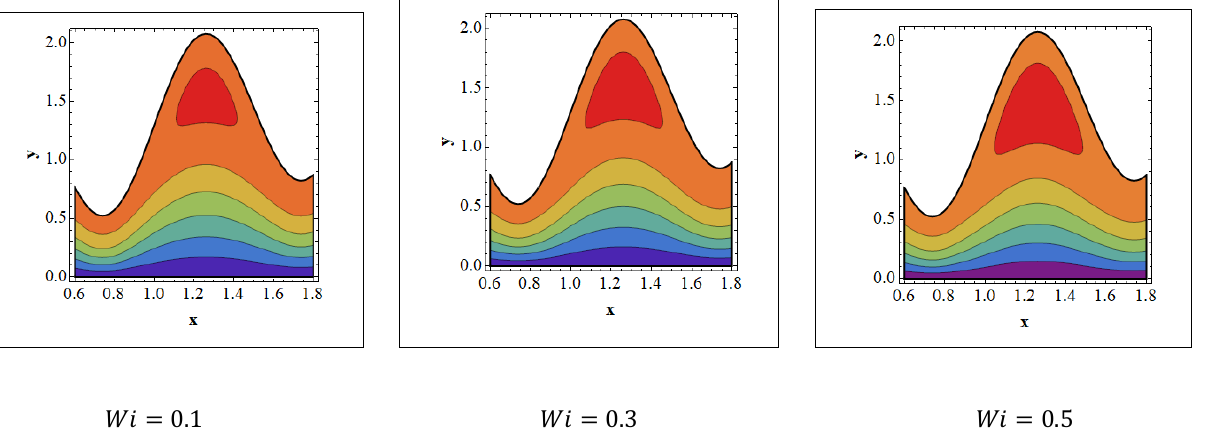
Figure 8. Streamlines for Weissenberg number. Values of other physical parameters are N t = 0.3, N TC = 1.2, N b = 0.4, b = 0.7, a = 0.3, N CT = 0.9, Re = 0.5, S 1 = 0.3, R m = 0.5, G rc = 1.4, G rt = 0.5, G rF = 0.8, α = 0.8, Q = 3, (cid:101) η = 1, (cid:101) µ = 1.